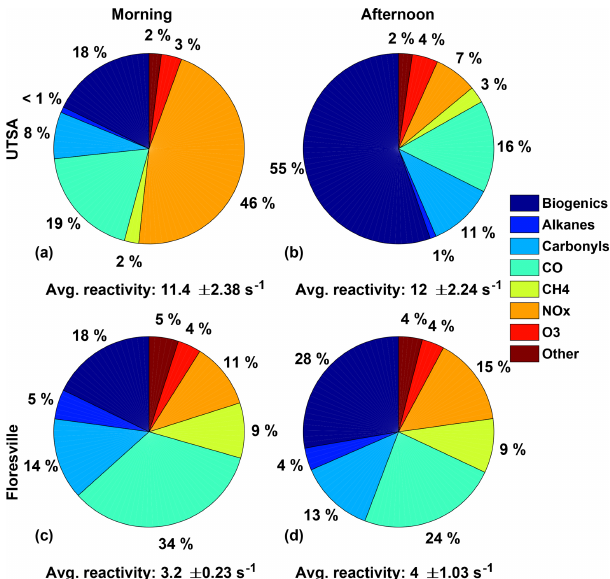
Figure 8. The distribution of the various contributors to the over- all OH reactivity for the UTSA (13–16 May) and Floresville (17– 19 May) sites is shown for both the morning, for times between 07:00 and 11:00, and the afternoon, for times between 13:00 and 20:00. The average OH reactivity ( ± 1 σ ) is also